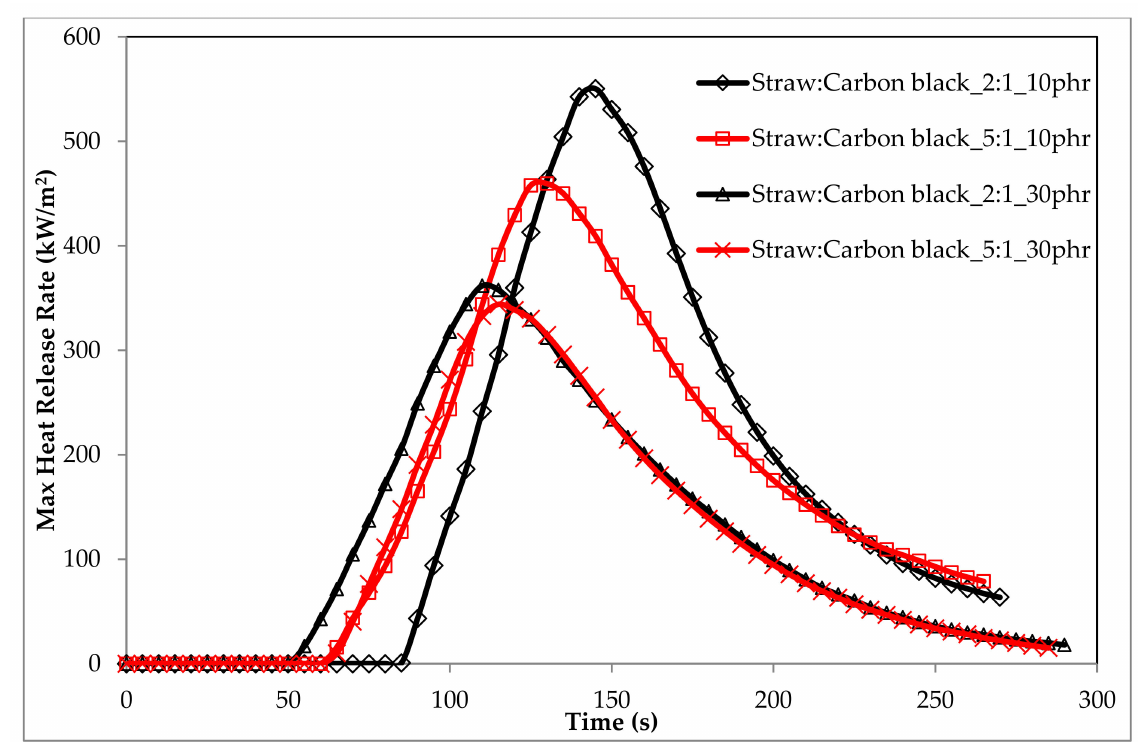
Figure 20. Comparison of HRR MAX curves containing the straw:carbon black filler in a weight ratio of 2:1 and 5:1, respectively.